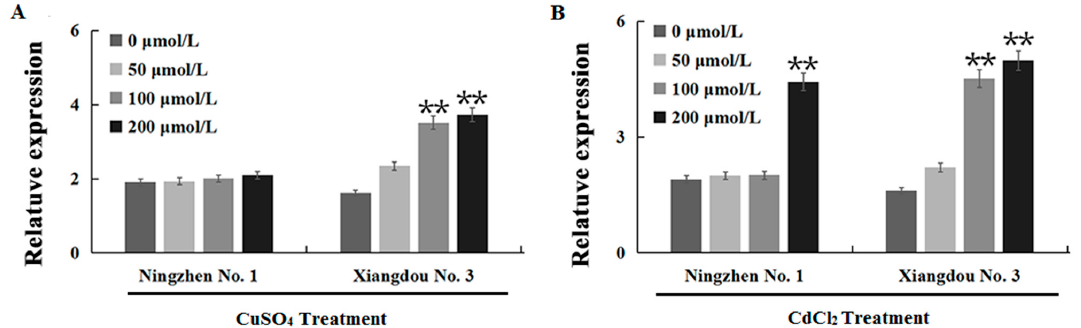
Figure 6. Expression pattern of GmATX1 in soybean cvs. Ningzhen No. 1 and Xiangdou No. 3 under heavy metal stress. ( A ) The relative expression of GmATX1 under different concentrations of CuSO 4 stress (for 24 h) in roots of 2-week-old soybean seedlings. ( B ) The relative expression of GmATX1 under different concentrations of CdCl 2 stress (for 24 h) in roots of 2-week-old soybean seedlings. ** Indicates significant differences between the control and treatments at p < 0.01. Values are mean ± SD from three biological replicates.